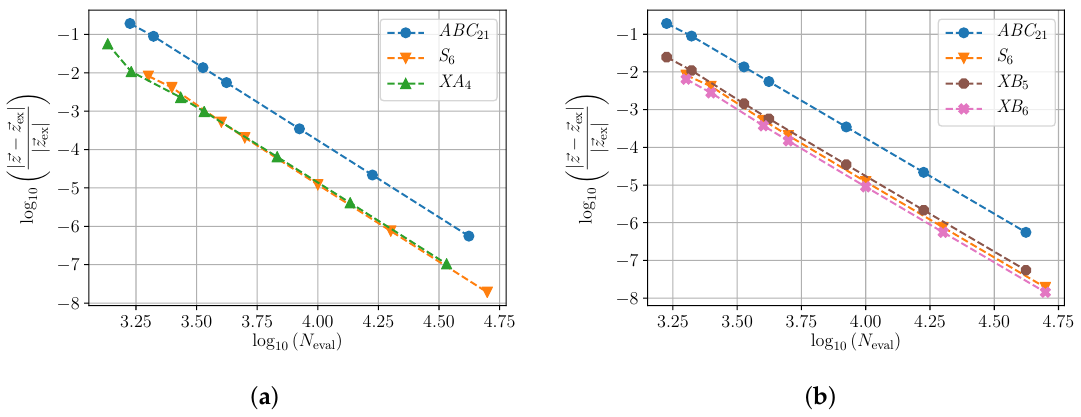
Figure 2. Relative error in the ( x , v ) space for charged particle under Lorentz force. The notation is the same as in Figure 1. ( a ) Relative error in the ( x , v ) space for XA 4 compared to ABC 21 and S 6 . ( b ) Relative error in the ( x , v ) space for XB 5 and XB 6 compared to ABC 21 and S 6